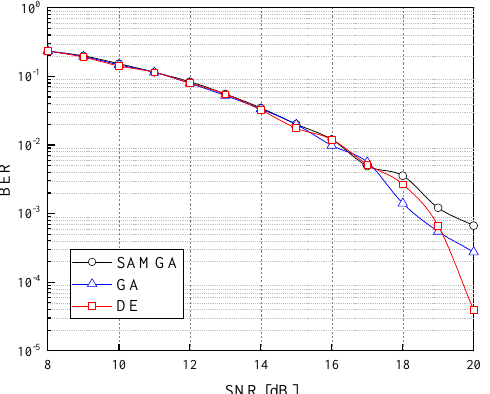
Figure 3. Bit error rate statistics of three estimators on the improved model with CFO values varying as a polynomial function.